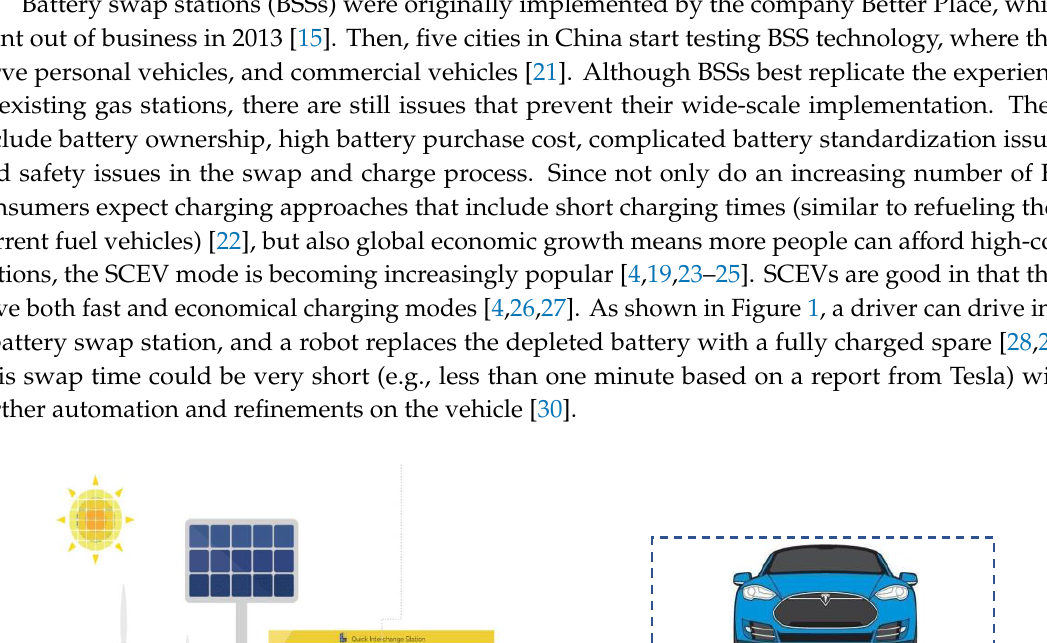
Table 2. Comparisons between the SCS mode and SSCS mode *.